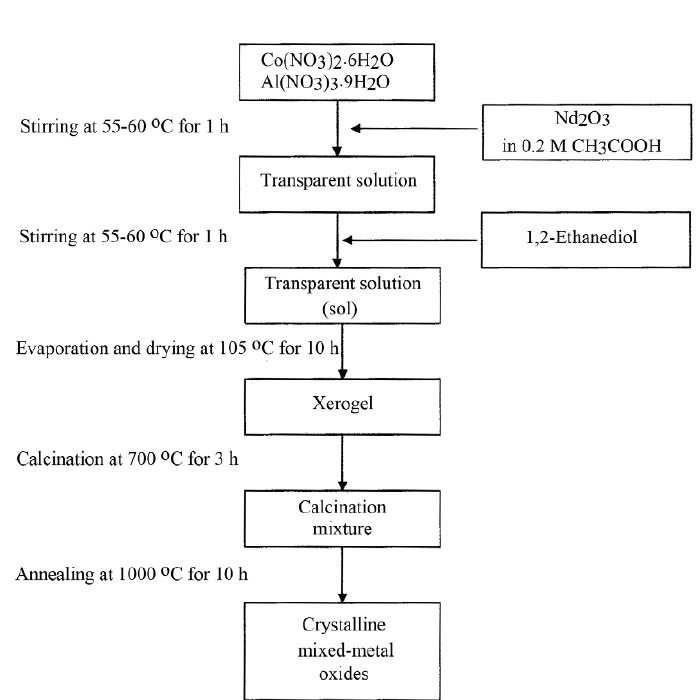
Figure 1. Scheme of sol-gel preparation of CoAl